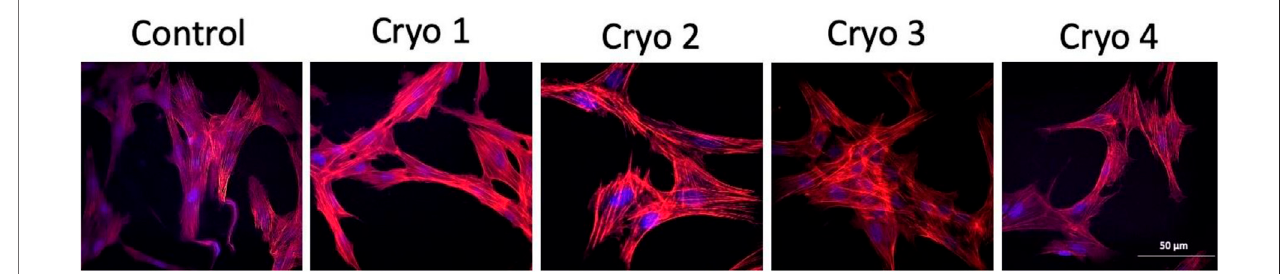
FIGURE5| Representativeimagesofthenon-frozen(Control)andfrozen/thawed(Cryo1throughCryo4)AT-MSCscellsstainedforthedetectionofactin fi laments using TRITC-conjugated Phalloidin (red color) and the nucleus of the cells revealed with DAPI (blue color).